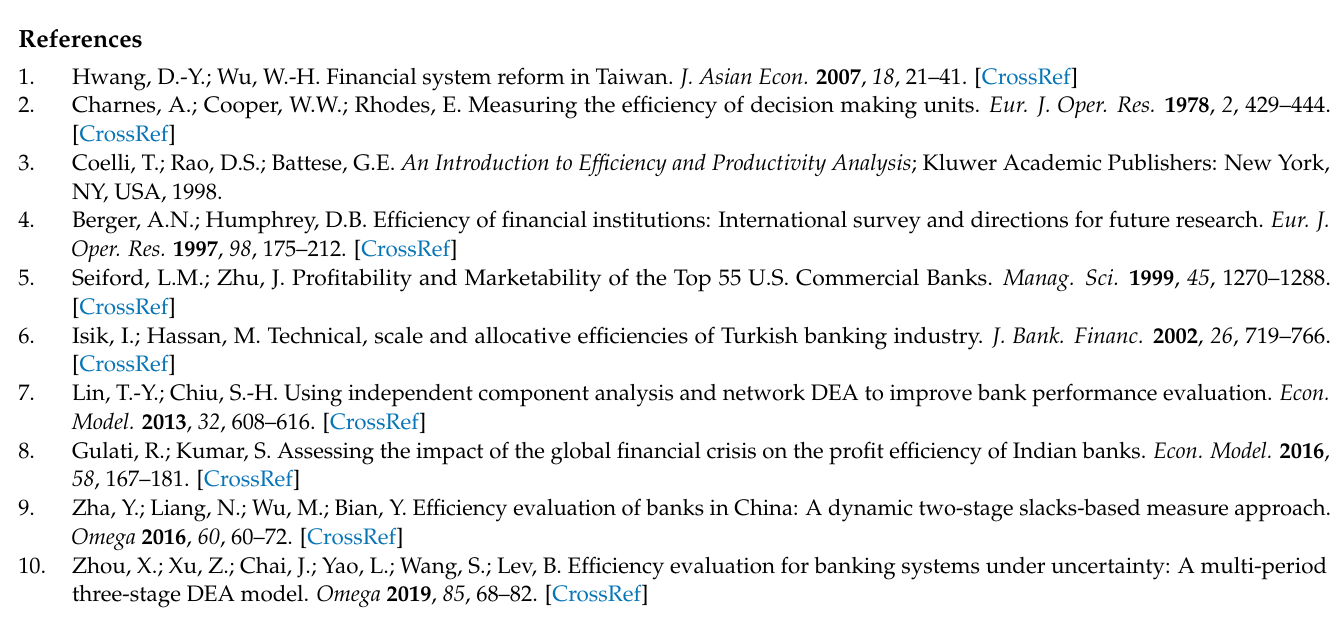
Panel C: λ = 1, α = 0.2, ω =